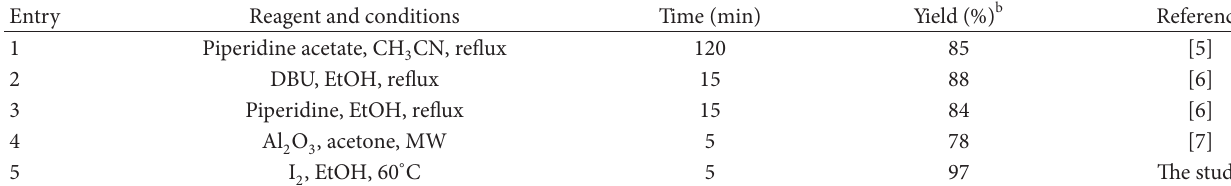
T 3: Comparison of the effect of catalysts in synthesis of 3a